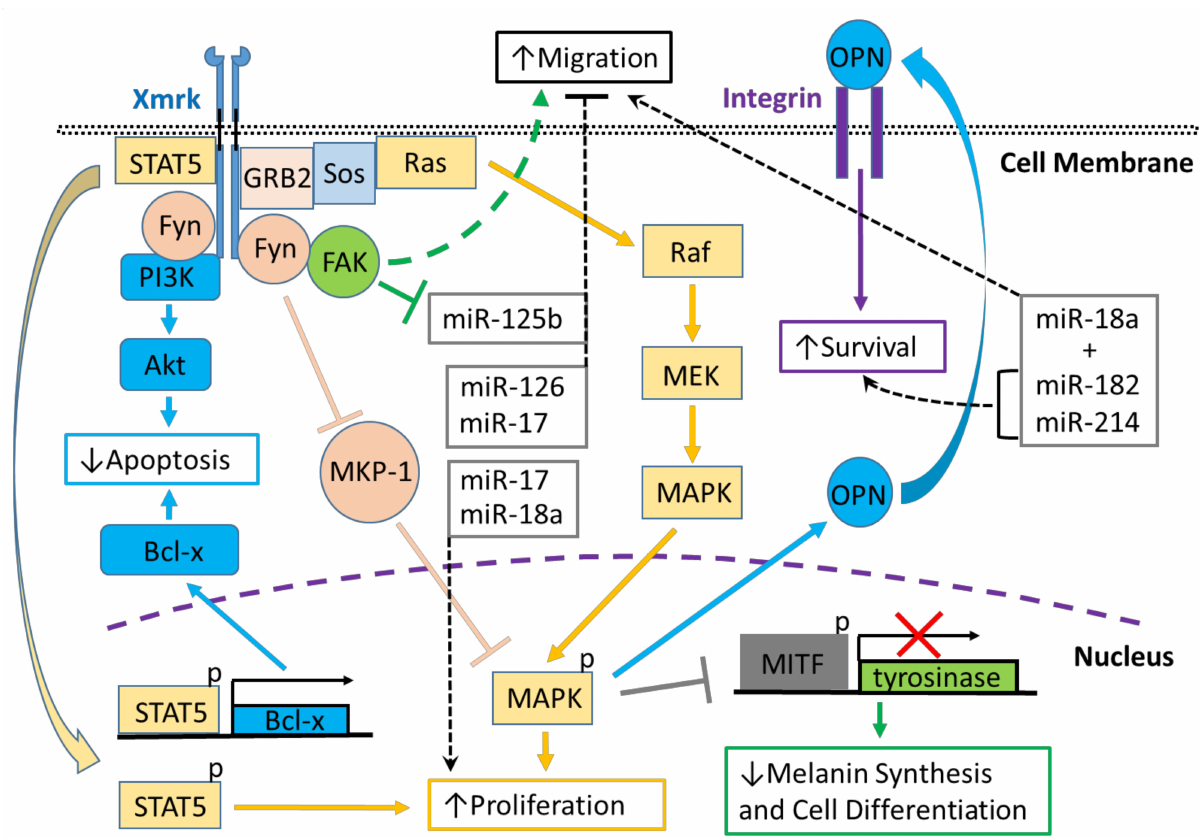
Figure 1. Xmrk signaling in the Xiphophorus melanoma model. Xiphophorus melanoma receptor kinase (Xmrk) is a receptor tyrosine kinase that recruits and activates several kinases, transcription factors and adaptor proteins integrated into signaling networks to regulate pigment cell cancer transformation. Activation of the kinase, phosphoinositide 3-kinase (PI3K), prevents apoptosis in malignant cells, as does activation of the transcription factor, signal transducer and activator of transcription 5 (STAT5), via B-cell lymphoma (Bcl-x) signaling, and STAT5 also promotes proliferation. The Src kinase protein, Fyn, acts as a docking protein and, through focal adhesion kinase (FAK), can induce pigment cell migration. Further, Fyn inhibits MAPK phosphatase 1 (MKP-1), a repressor of MAPK, causing the promotion of MAPK’s function to increase melanoma cell proliferation. Xmrk can also signal via the adaptor proteins, GRB2 and Sos, to activate the Ras/Raf/MEK/MAPK pathway, thereby enhancing proliferation. Additionally, MAPK signaling causes degradation of the transcription factor, microphthalmia transcription factor (MITF), leading to reduced transcription of tyrosinase, which decreases melanin synthesis and inhibits pigment cell differentiation. Another function of activated MAPK is to induce the synthesis of osteopontin (OPN), which is secreted, binds to integrins on the cell membrane surface, and promotes pigment cell survival. Several miRNAs that are regulated in fish Xmrk models also have functions in human melanoma. The miRNAs miR-18a, -182, and -214, can act to promote migration in human melanoma, while miR-182 and -214 can also stimulate cell survival. MiR-17, 125b, and -126 act to inhibit melanoma cell migration, with -125b’s action inhibited by FAK. MiR-17, along with miR-18a, also function to increase melanoma